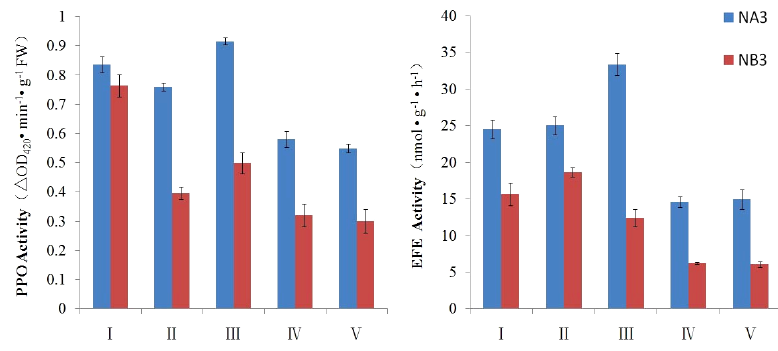
Figure 2. The activities of PPO and EFE in CMS and its maintainer line during different development stages. Error bars indicate standard deviation. Roman letters I to V marked represent the five stages of flower buds indicated in Figure